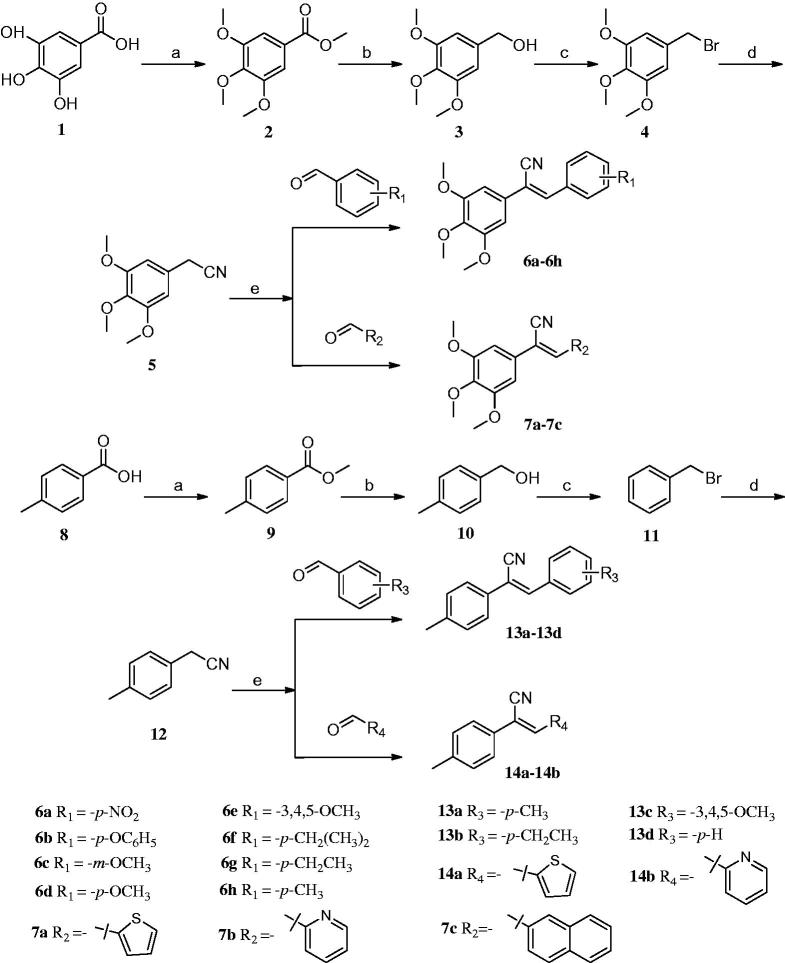
Reagents and conditions: (a) (CH3)2SO4, (CH3)2CO, K2CO3, reflux; (b) LiAlH4, THF, 0 °C-rt, 4–6 h; (c) CH2Cl2, PBr3, 0 °C-rt, 3–6 h; (d) CH3CN, TMSCN, TBAF, reflux, 4–6 h; (e) CH3OH, CH3ONa, aromatic aldehydes, 4–6 h.